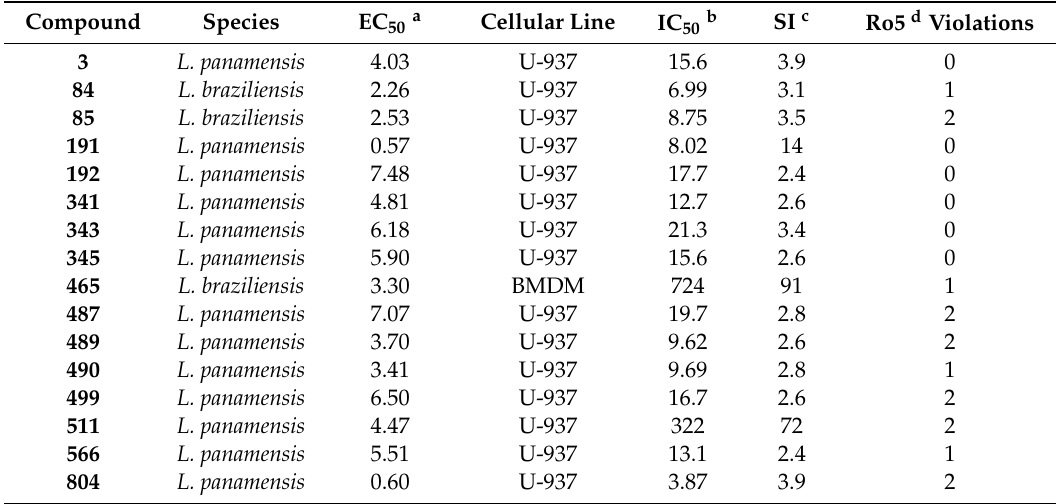
Table 4. Selected candidates after Pan-Assay INterference compounds (PAINs) filtering.